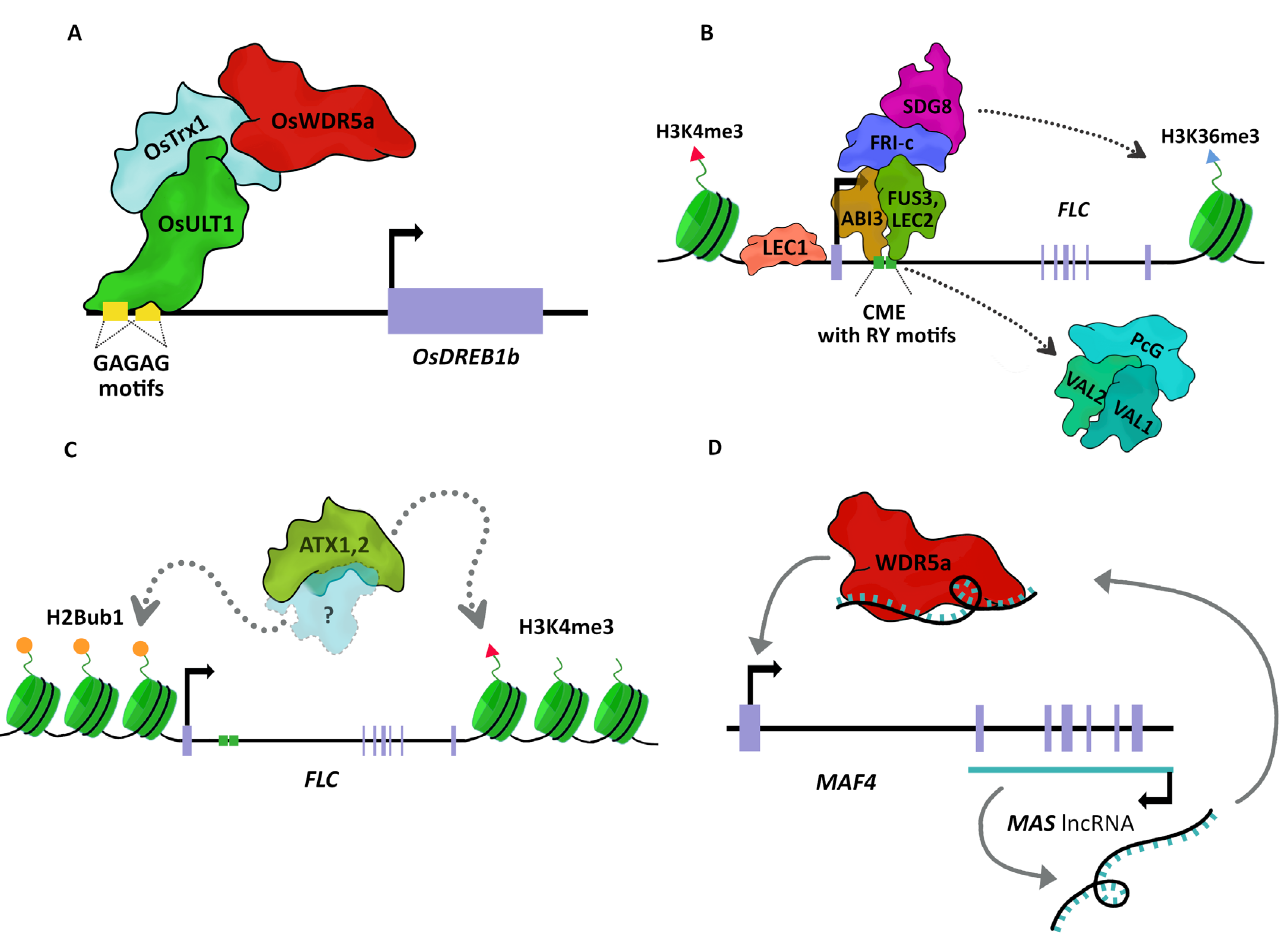
Figure 1. Different forms of TrxG recruitment in plants. ( A ) OsULT1 recognizes GAGA motifs on the OsDREB1b promoter to recruit the OsTrx1 along with the COMPASS protein OsWDR5a to activate transcription. ( B ) The B3-domain transcription factors ABI3, FUS3, and LEC2 recognize the RY motifs on FLC large intron, displacing PcG factors (including VAL1 and VAL2) (illustrated by an arrow) and recruiting FRI-complexed (FRI-c) with TrxG-SDG8 proteins to activate FLC transcription through the H3K36me3 deposition (indicated by an arrow). In this model, LEC1 binding increases chromatin accessibility into CME. ( C ) The H2Bub1 histone modification is recognized by an unknown protein (indicated by an arrow) that interacts with ATX1,2 to regulate FLC expression through the deposition of the H3K4me3 mark (indicated by an arrow). ( D ) The MAS antisense lncRNA transcribed from the MAF4 locus interacts with WDR5a and may function as a guide to direct the recruitment of WDR5a at its target (interactions illustrated by arrows). CME: cold memory